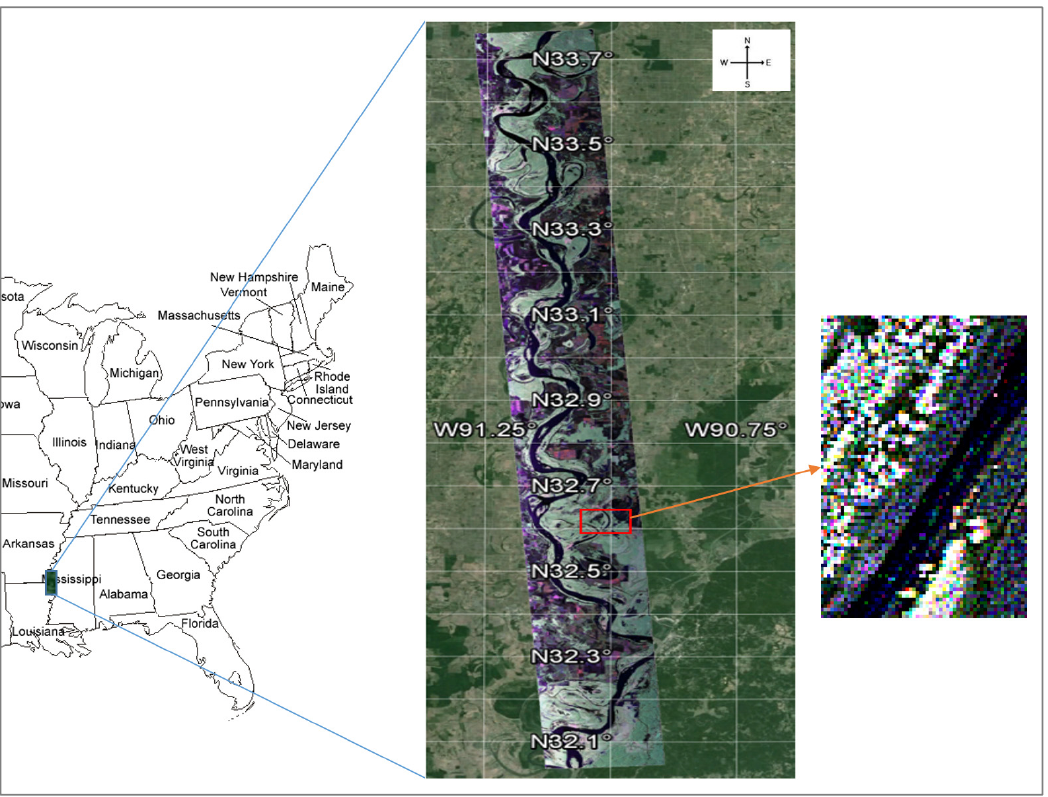
Figure 4. Study area with a radar color composite three ‐ band (HH, VV, and HV) image overlaid on a base map.